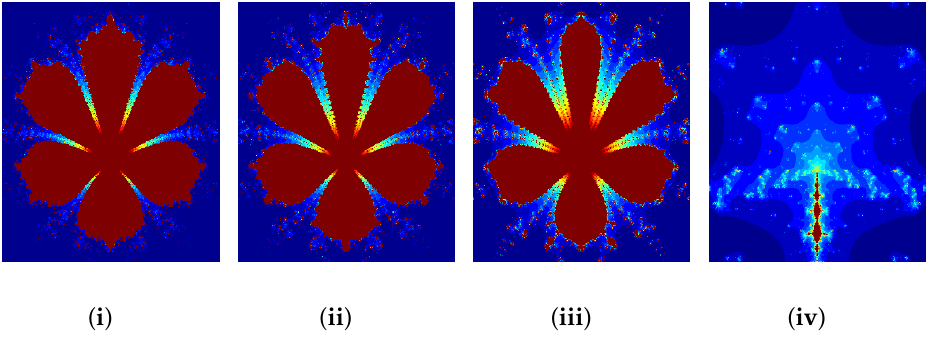
Figure 15. Septic Julia sets in ( i ) Noor-orbit; ( ii ) Ishikawa-orbit; ( iii ) Mann-orbit; ( iv ) Picard-orbit. The change in sign in parameters a and c leads to reflexive and rotational